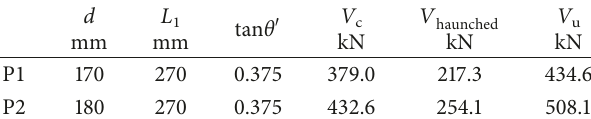
Table 5: Calculation of the shear strength.